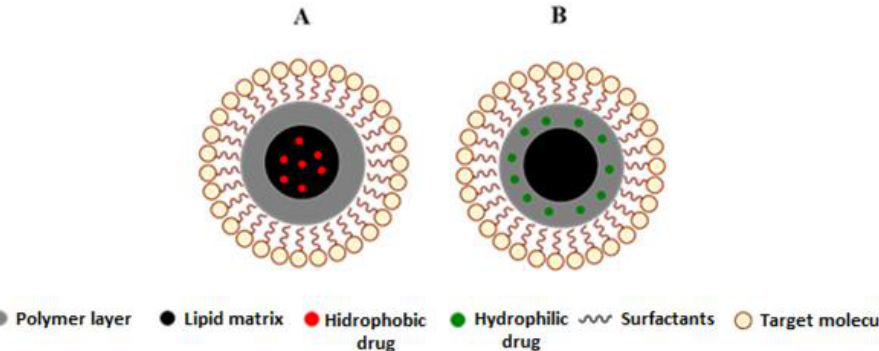
Figure 5. ( A ) Hydrophobic drugs encapsulated in the lipid matrix and ( B ) hydrophilic drugs ad- to the polymeric hered to the polymeric layer.